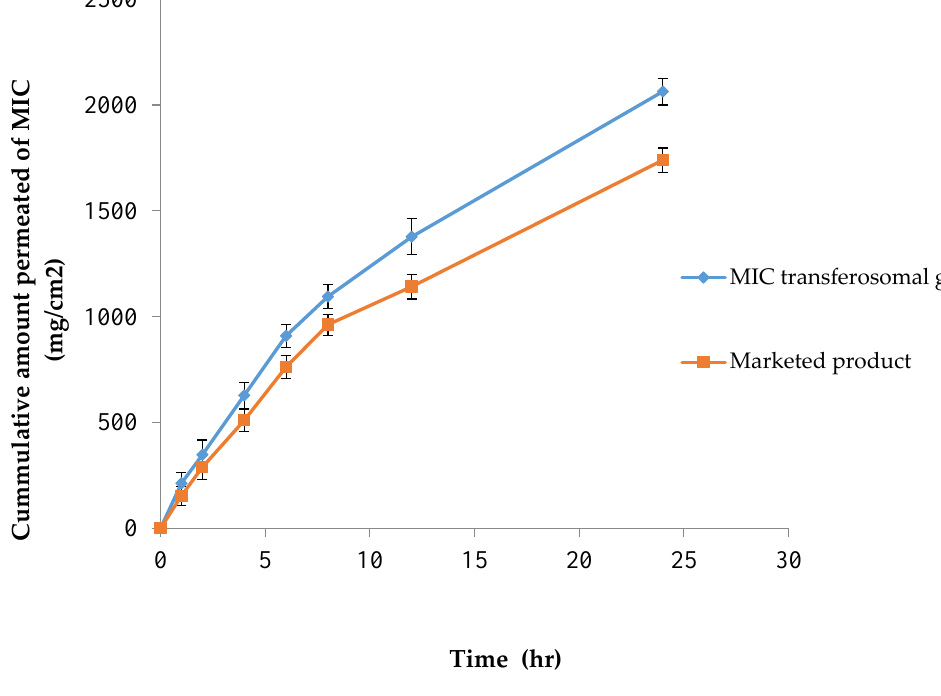
Figure 9. The cumulative amount of MIC which permeated through rat skin from the transfersomal gel in comparison with Daktarin®cream